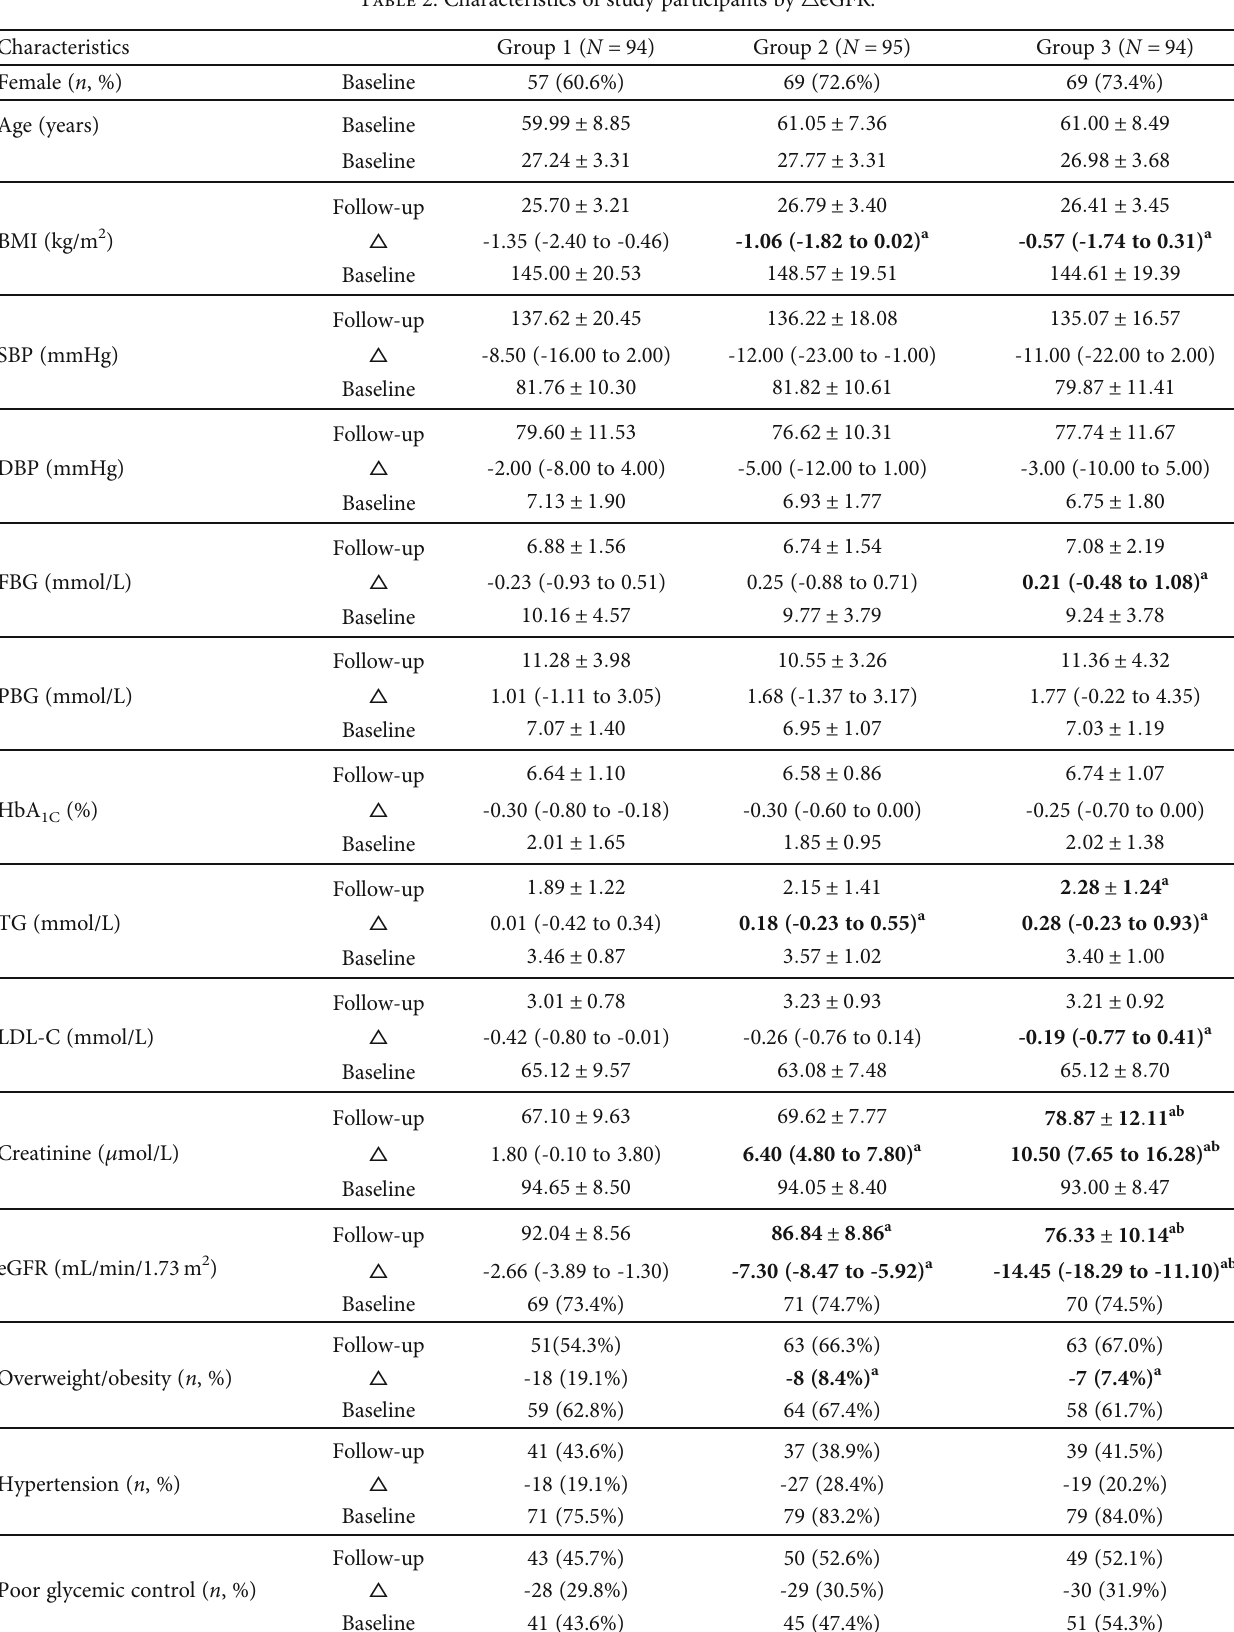
Table 2: Characteristics of study participants by △